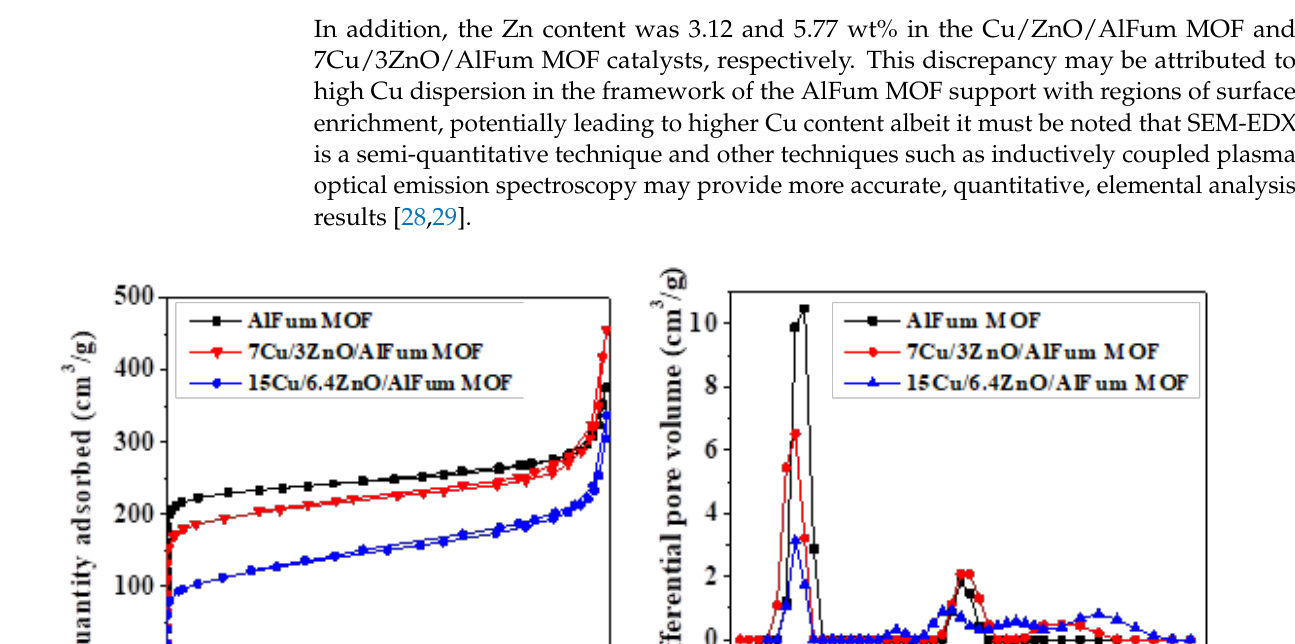
Table 1. S BET , pore volume, mean pore size diameter, and elemental composition of pristine AlFum MOF and Cu/ZnO/AlFum MOF catalysts.